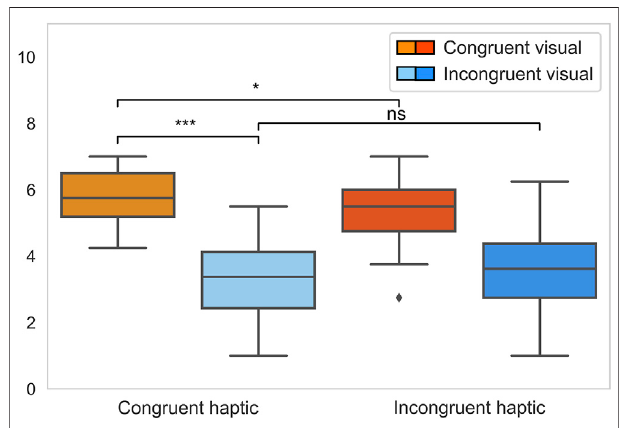
FIGURE 8 | Ownership scores across conditions, computed for each participant using the mean of answers to the corresponding questions in the last four blocks of the